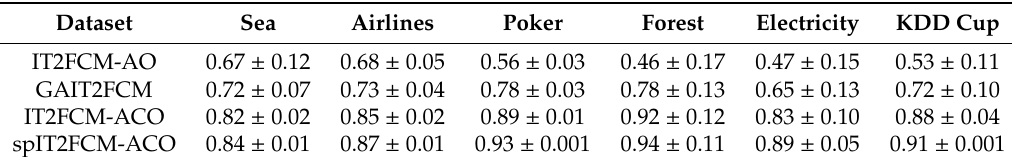
Table 5. Evaluation of FRI.